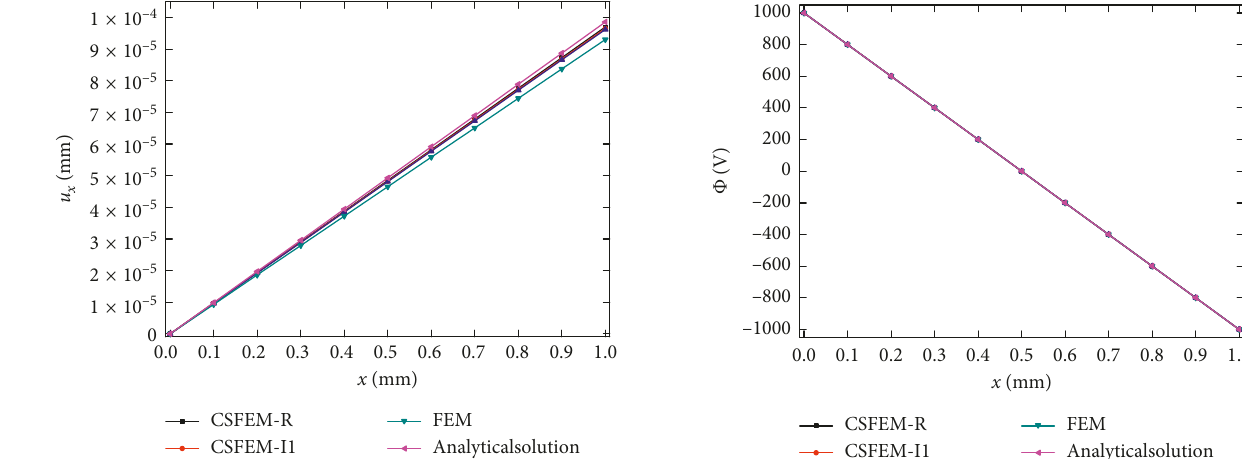
at the central line ( z Φ